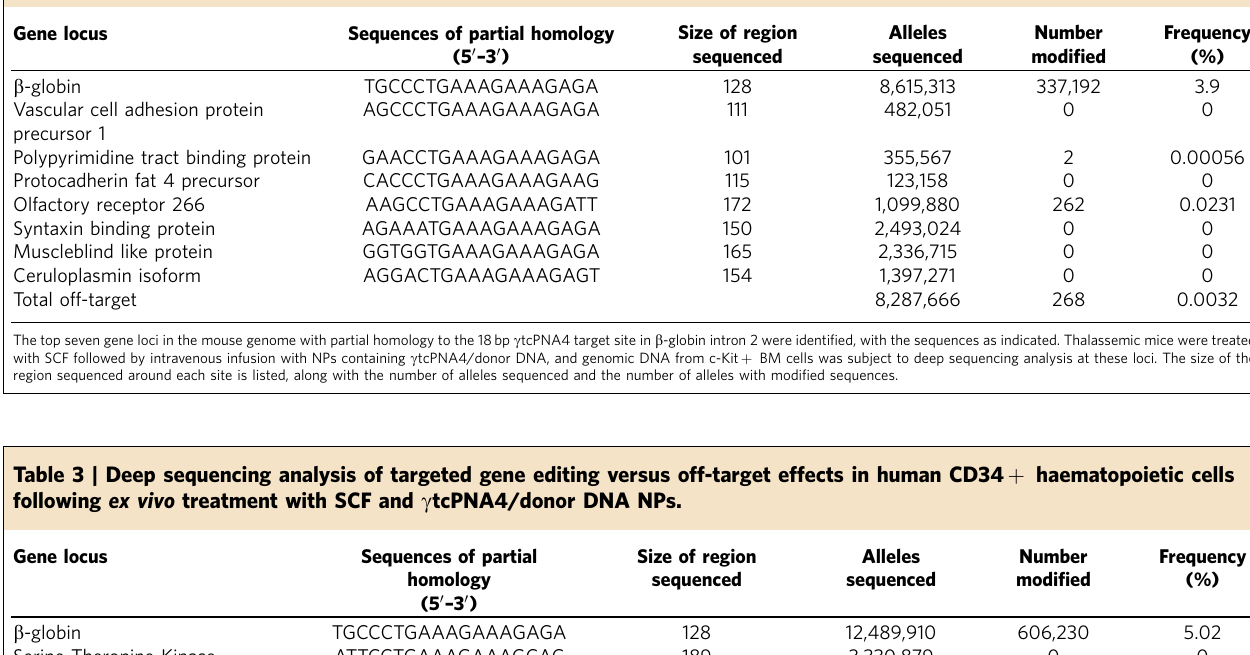
Table 2 | Off-target effects in bone marrow cells following intravenous treatment of b -thalassemic mice with SCF and g tcPNA4/ donor DNA NPs.